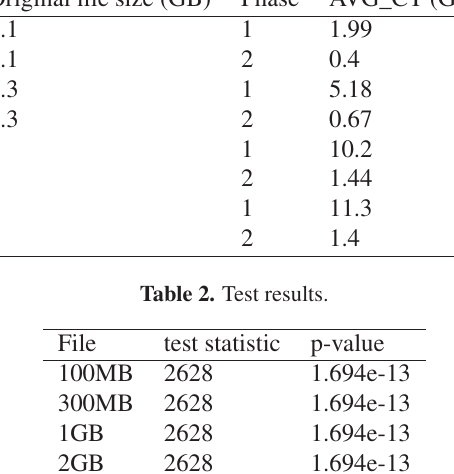
Figure 3. Throughput bottleneck.